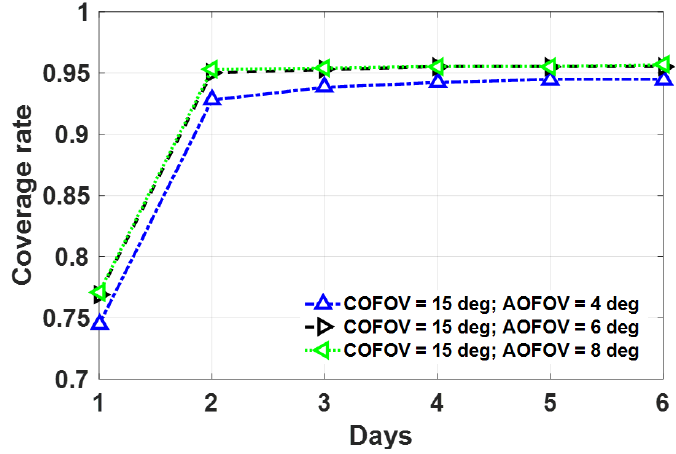
Figure 5. Sensor coverage rate with cross-orbit FOV value of 15° and along-orbit FOV value from 4° to 8°.